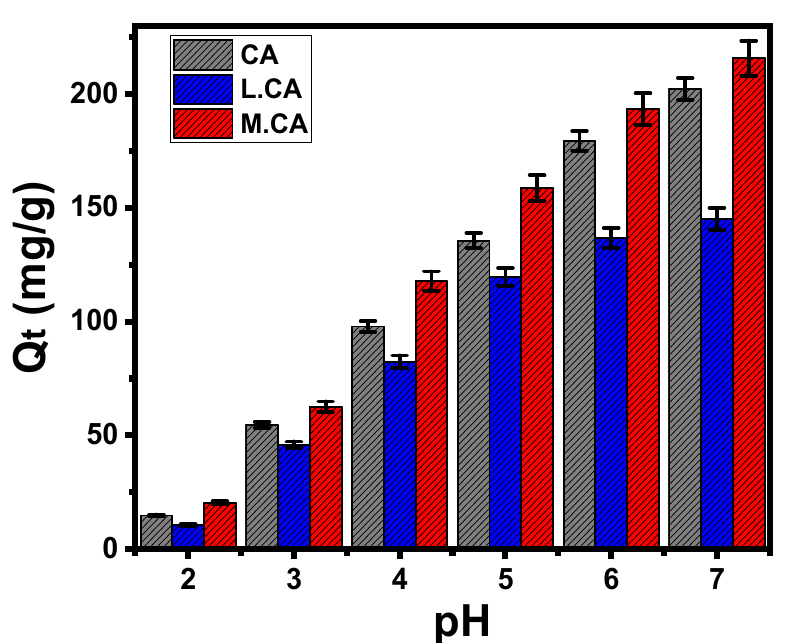
Figure 2. Effect of the solutions pH on the uptake of Zn (II) by the three calcite forms.